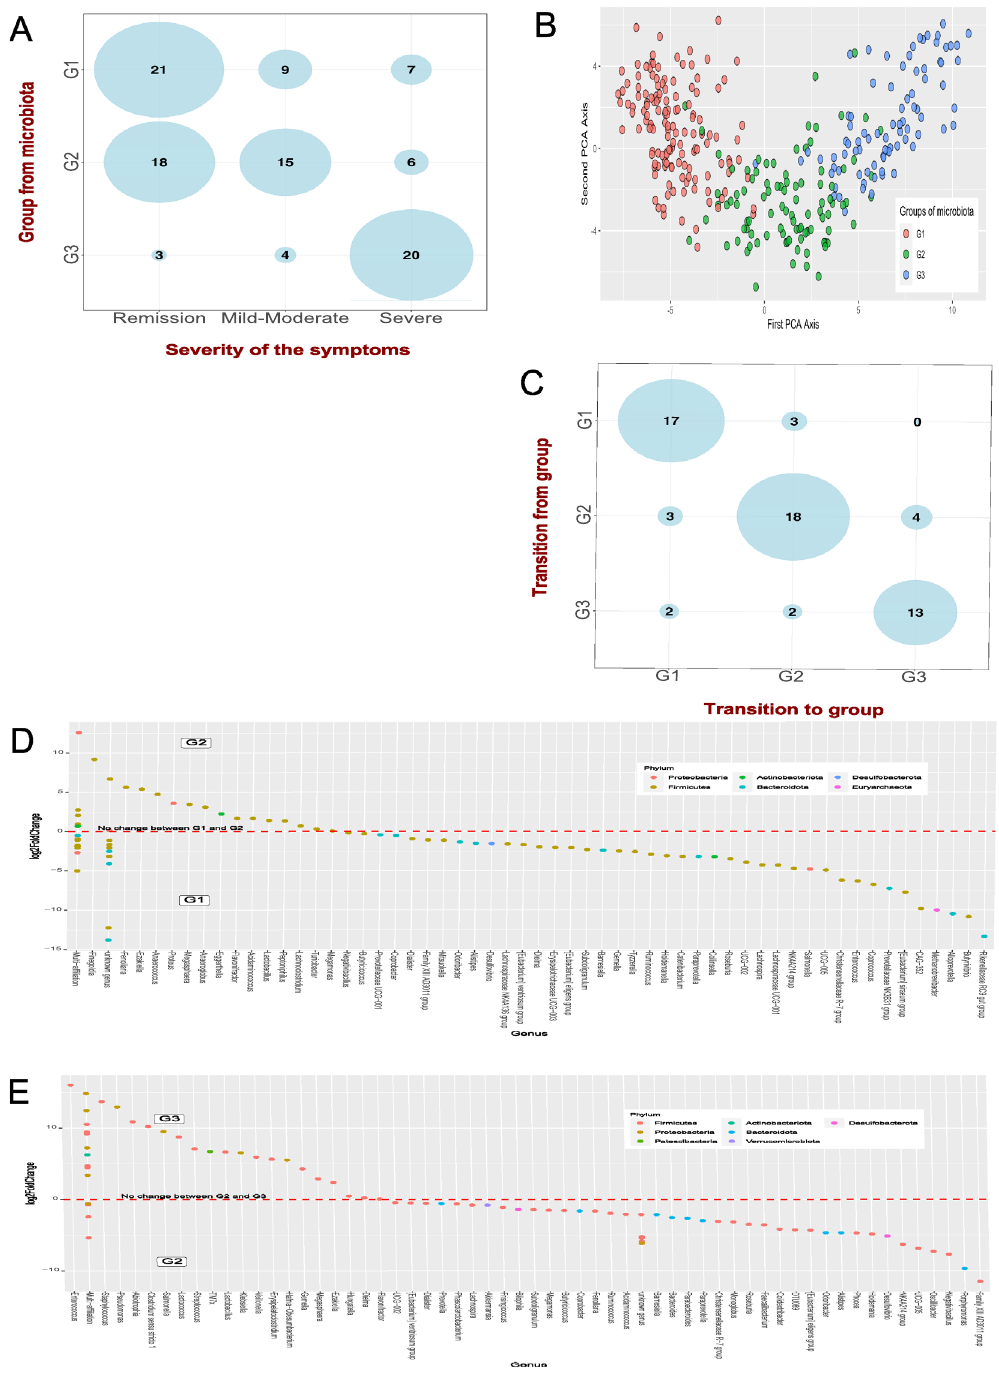
Figure 2. Gut microbiota from 41 CD patients (n = 103 several consecutive samples). ( A ) Association between the groups of gut microbiota G1, G2 and G3 and severity of the symptoms in CD patients. From the groups G1 to G3, an increase in symptoms severity is observed (p = 3.46e−6). ( B ) Projection of the three groups of gut microbiota G1, G2 and G3 with principal component analysis (PCA): G1, G2 and G3 are represented by three different colors. ( C ) Transition of the three groups of gut microbiota G1, G2 and G3 between two consecutive samples: overall, CD patients remain in the same group over time. ( D ) Significant (p < 0.05) log-fold changes in the abundances of bacterial species in G2 compared to G1. Positive log-fold change points out an increase in abundance in G2 compared to G1, while negative log-fold change points out a reduction in abundance. ( E ) Significant (p < 0.05) log-fold changes in the abundances of bacterial species in G3 compared to G2. Positive log- fold change points out an increase in abundance in G3 compared to G2, while negative log-fold change points out a reduction in